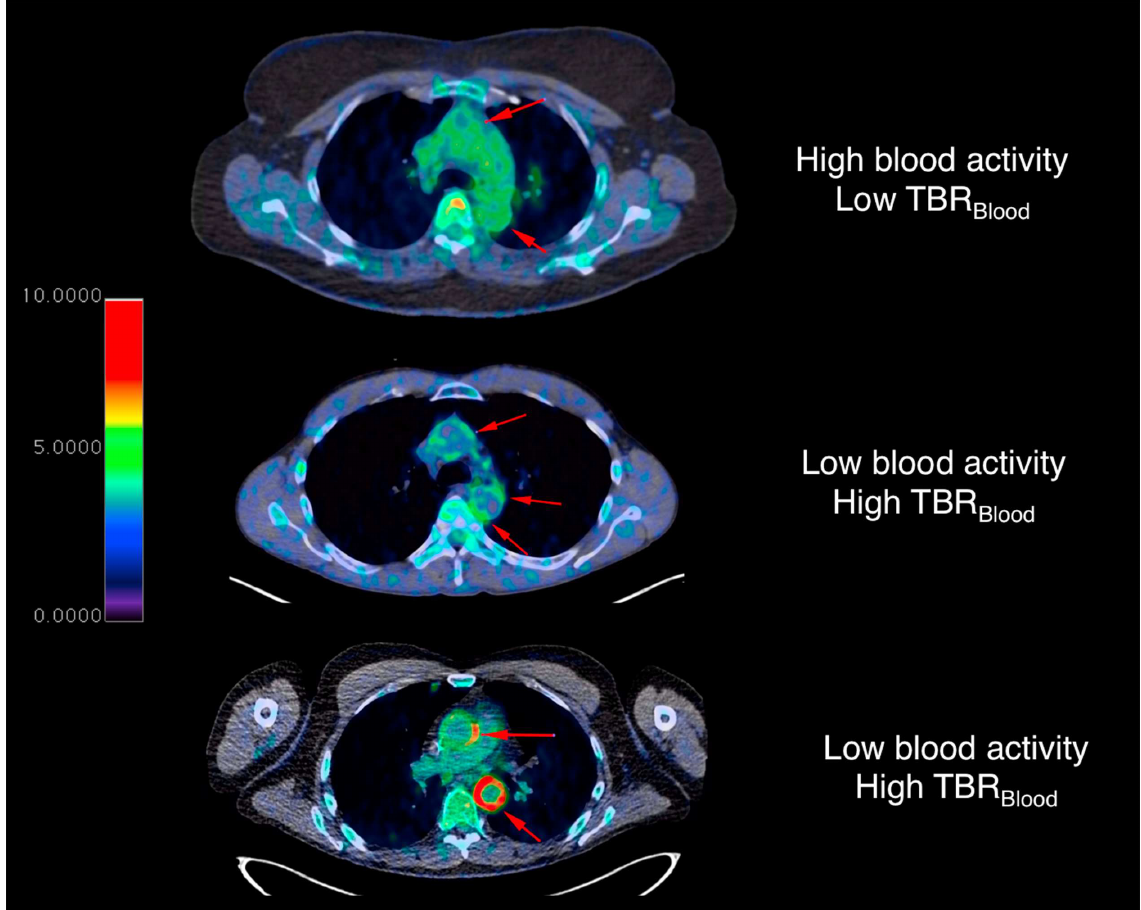
Fig 1. Examples of variation in blood activity and aorta wall FDG uptake. PET (color) and CT (black/white)axial fusion images just belowthe aortic arch of three subjects, using identicalwindowing and levelingof PET SUV accordingto the look up table (left). Red arrows point to regions where aorta wall activity is expected. The top subject has low TBR Blood with high levels of blood activity in the aorta lumen (green). The middle subject has lower blood activity in the lumen of the aorta, which allows visual contrast of the aorta wall, therefore higherTBR Blood . It is not clear if the difference in TBR Blood between the top two subjects is related to differences in inflammation or due to differences in blood activity. However, comparedto a subject with active large vessel vasculitis (bottom), there is clearly abnormalaorta wall activity that can be distinguished from blood